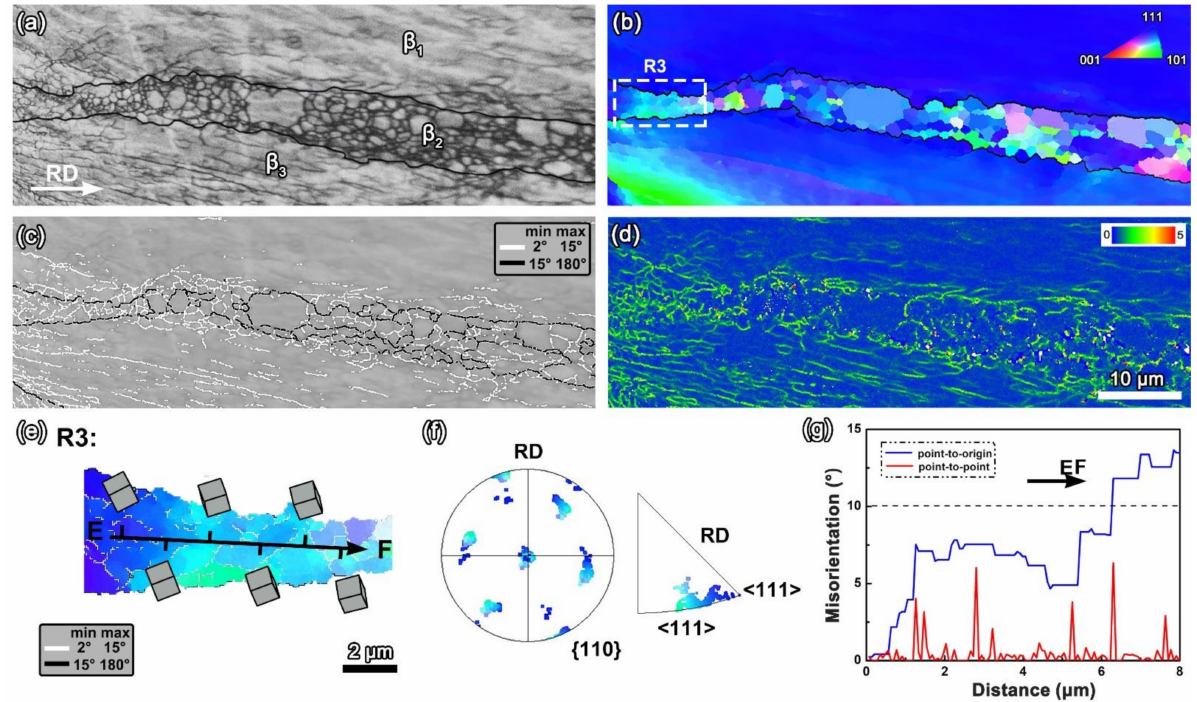
Figure 4. Analysis of geometric static recrystallization mechanism in the larger deformed β grain of specimen HT-1: ( a ) BC map; ( b ) IPF map; ( c ) grain boundaries misorientation; ( d ) KAM map; ( e – g ) the misorientation angle along black arrow EF and (110) pole figure.